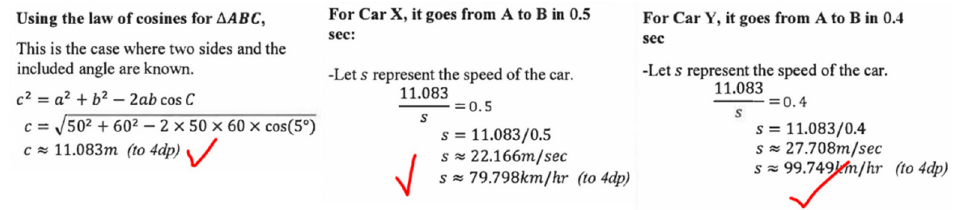
Figure 6. Recaptured student’s work correctly solved the second problem by right triangles. Table 8. Effect of different strategies on the performances in solving the second word problem.